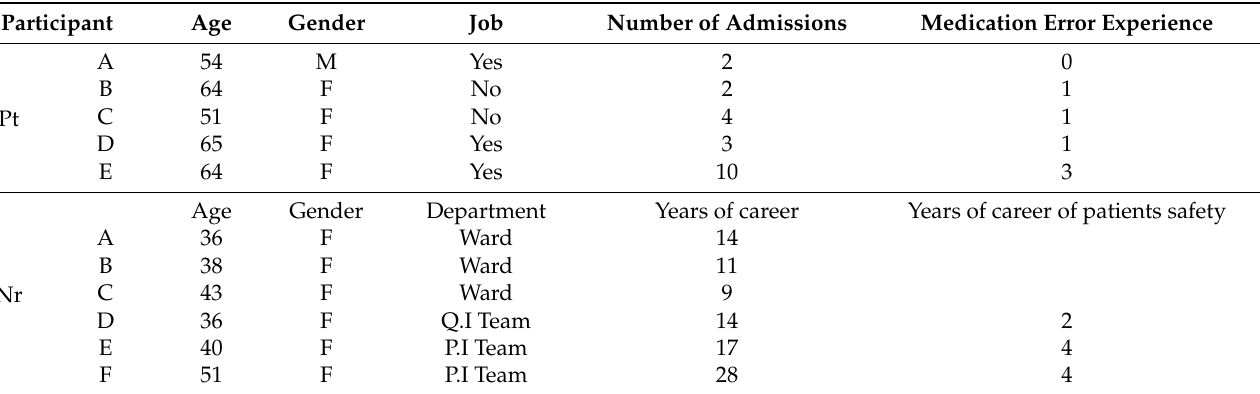
Figure 1. Flowchart of decisions made for selection, critical appraisal, and data extraction for the theoretical phase. Table 1. General Characteristics of